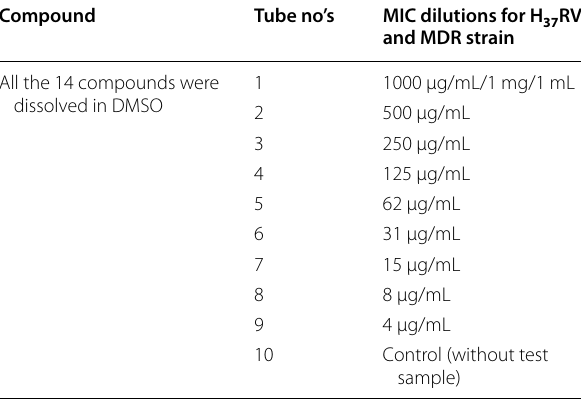
Table 2 Minimum inhibitory concentration (MIC)